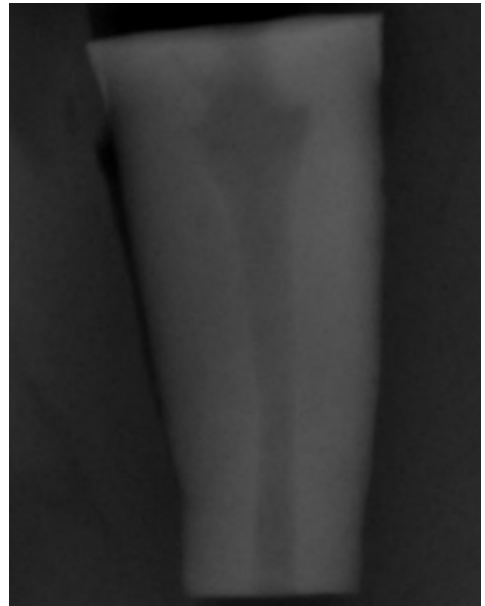
Figure 1. Periapical radiograph to demonstrate the simulation of the divergent apical architecture created with the retrograde instrumentation.